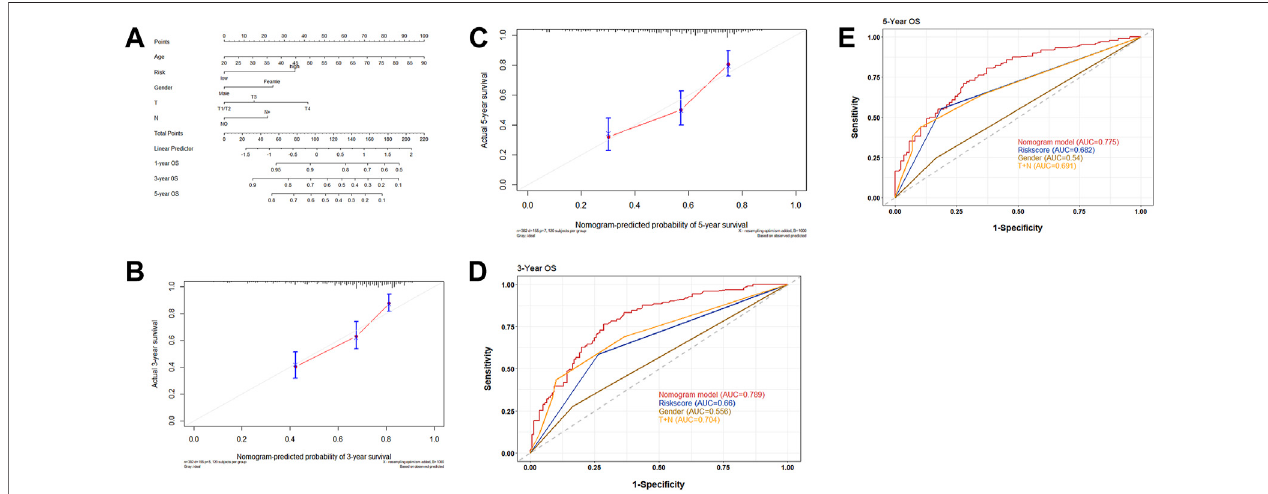
FIGURE 6 | (A) Nomograms integrated with clinical characteristics and risk score for predicting OS based on all the patients in two cohorts. (B) Calibration curves predicting 3-year OS. (C) Calibration curves predicting 5-year OS. (D) ROC curve for 3 years to assess the AUC of the gender, nomogram, and T + N stage. (E) ROC curve for 5 years to assess the AUC of the gender, nomogram, and T + N stage.